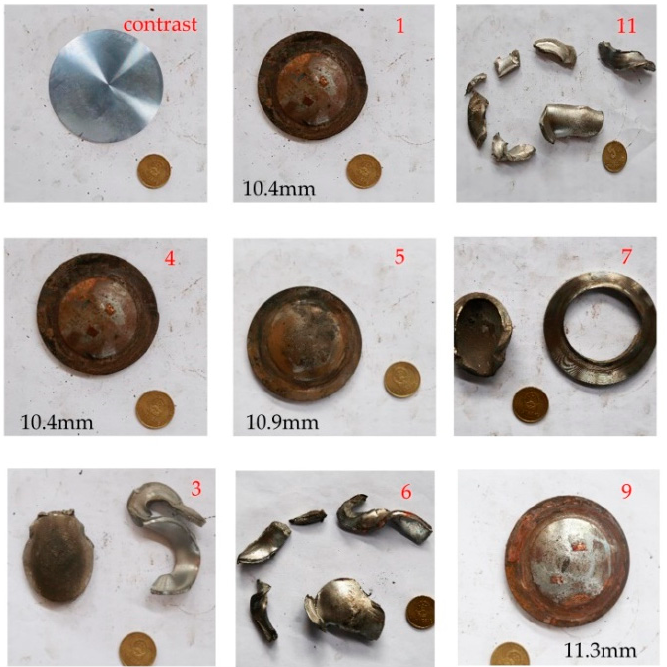
Figure 4. Displays after experiments of constant-stress shear plate (the maximum width of convex area of each constant-stress shear plate is shown in the figures).